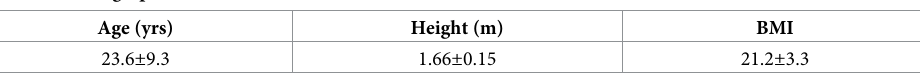
Table 2. Demographic characters.